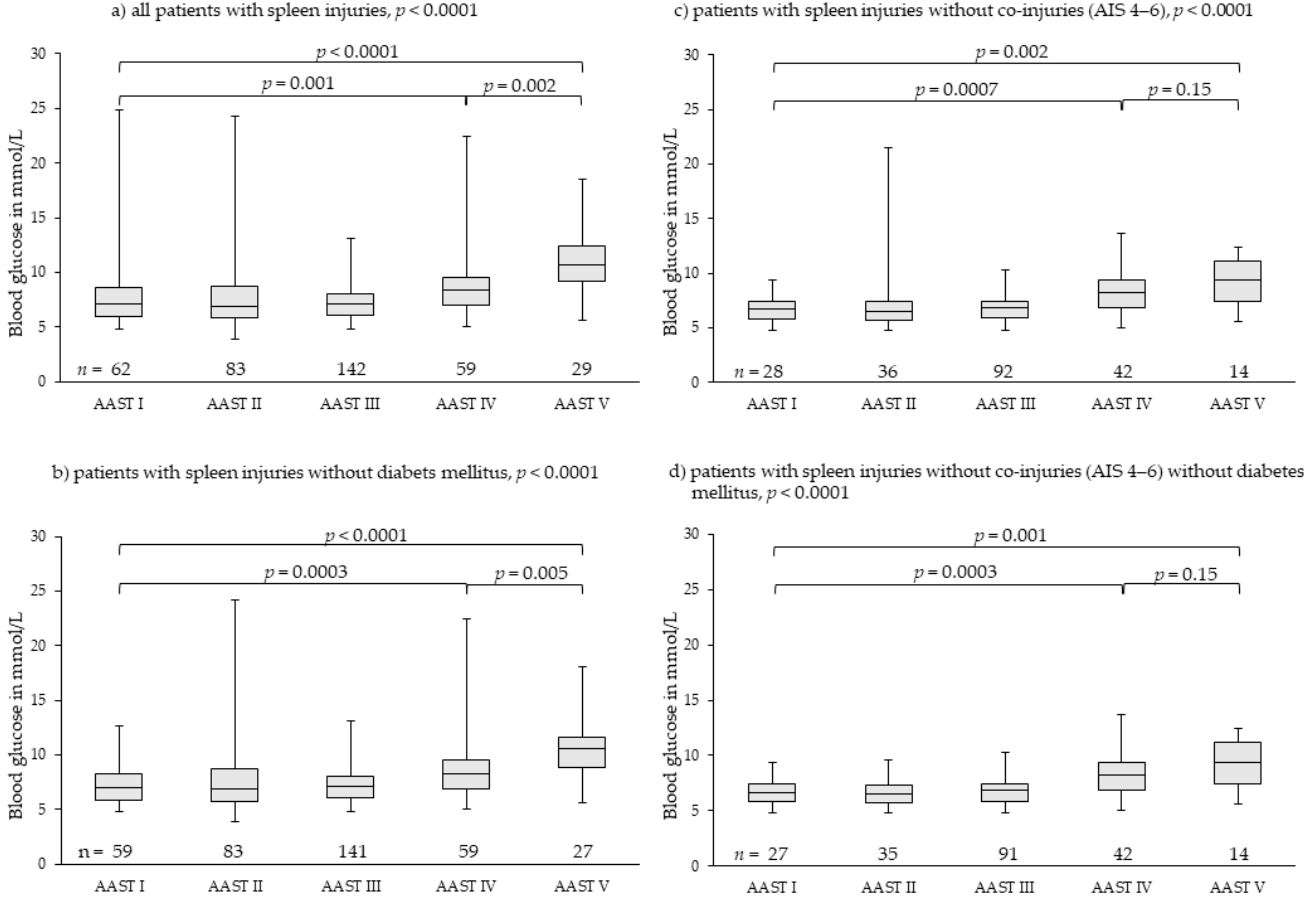
Figure 3. Rising blood glucose levels parallel to injury severity and hemorrhage in splenic injuries. Outliers of very high blood glucose levels in less severe injuries (AAST I-III) were found in patients with diabetes mellitus disease or severe co-injuries ( AIS 4 – 6 ) ( a – c ). In patients without severe co-injuries and without diabetes mellitus ( d ), the effect of injury severity and hemorrhage on blood glucose levels was demonstrated more clearly, meaning the greater the severity of injury and the hemorrhage extent, the higher the stress hyperglycemia including most severe splenic injuries (AAST V). AAST: American Association for the Surgery of Trauma [27,28]; AIS: Abbreviated Injury Scale [43].